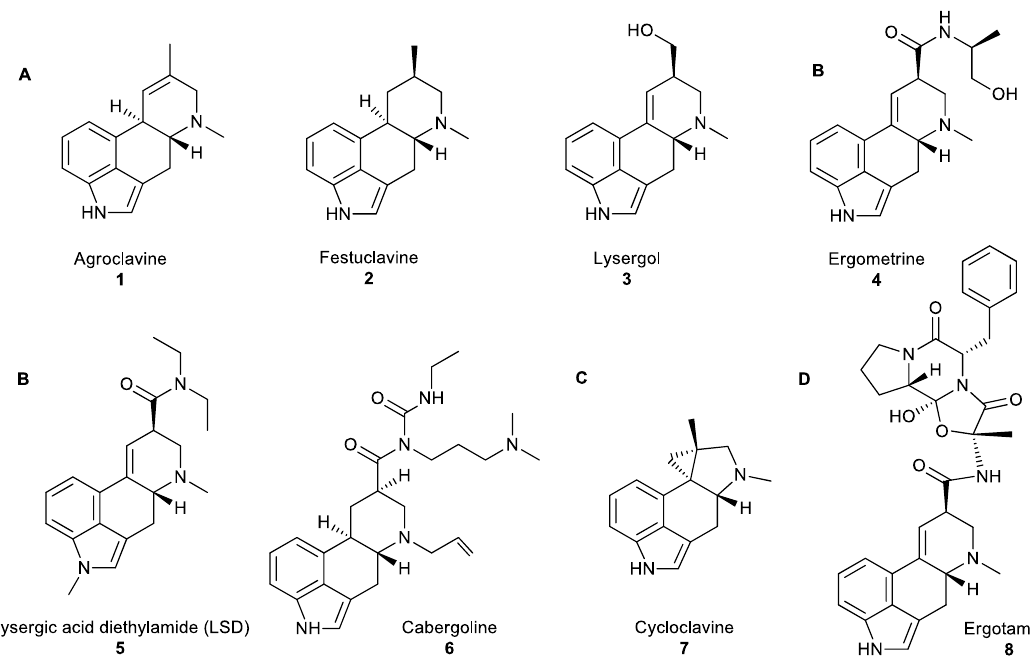
Figure 1. ( A ) Examples of clavines. ( B ) Simple lysergic acid derivatives. ( C ) The unusual ergoline scaffold of cycloclavine. ( D ) Ergopeptides consisting of D-lysergic acid with a cyclic tripeptide moiety [14].